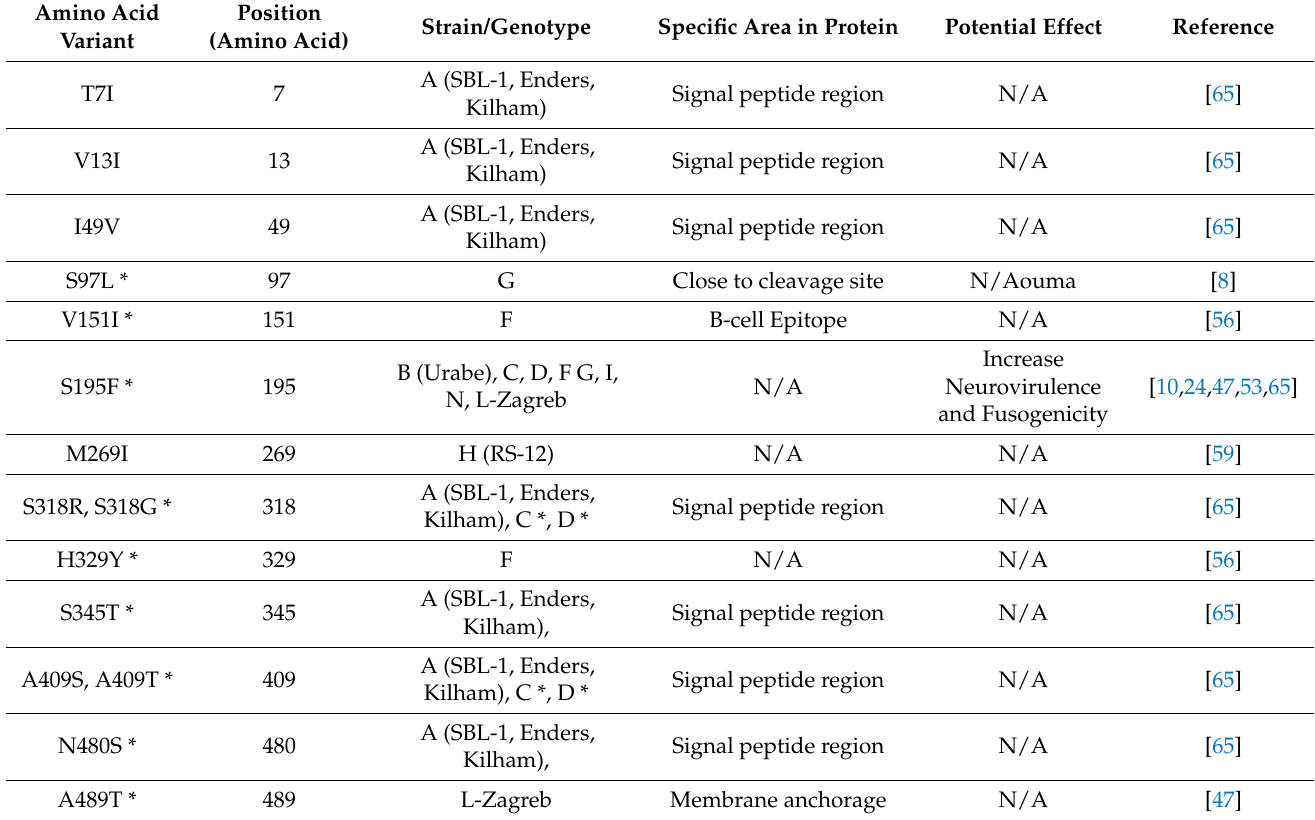
Table 3. List of known F protein amino acid variants and their